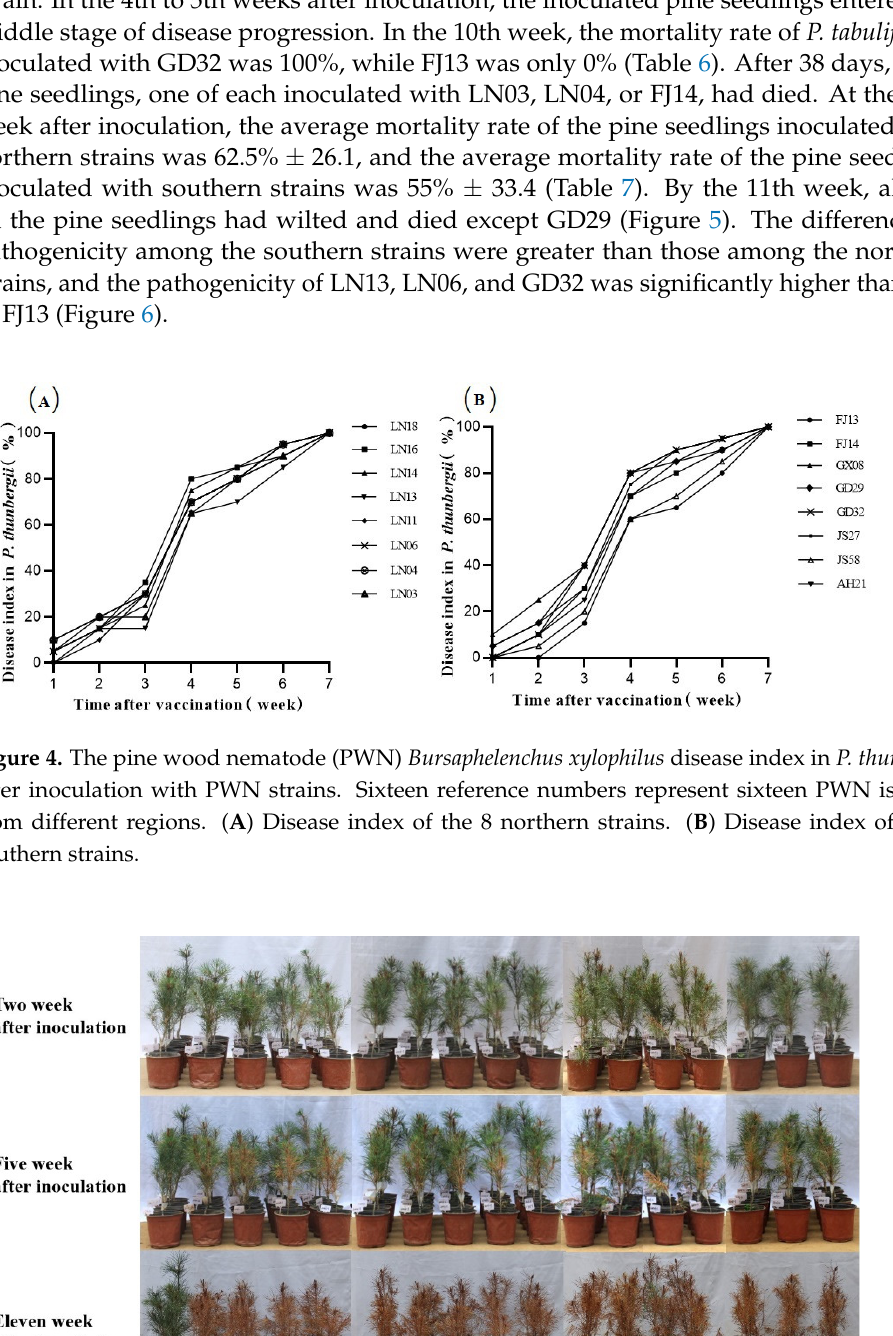
Table 6. The disease level and index and the mortality rate of P. tabuliformis after artificial inoculation with southern and northern PWN strains.